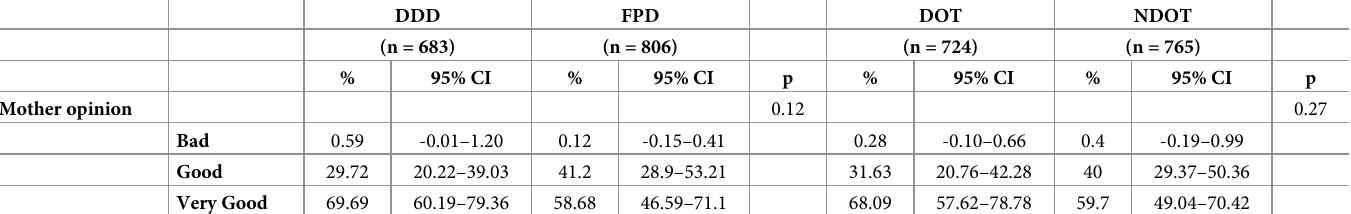
Table 6. Mother’s opinion on SMC according to the method of delivery (door to door versus fixed point) and the method of observation of the treatment (directly observed treatment versus not directly observed